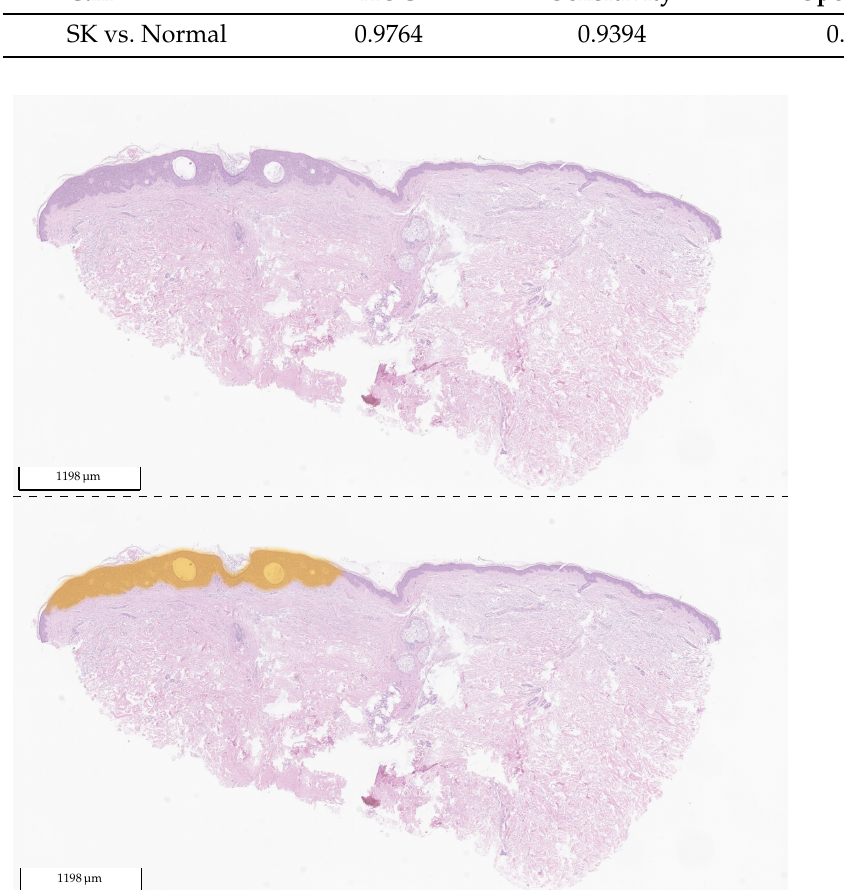
Figure 18. Exemplary tissue section of SK from the test set of Center 1 ( upper picture ) and the same tissue section with its corresponding 2 heat map overlays ( lower picture ): yellow (BD) and orange (SK). The probability value between 0 and 1 is used to set the transparency. As the model did not detect any BD in the section, no yellow is visible (fully transparent). The section was correctly classified by the algorithm as